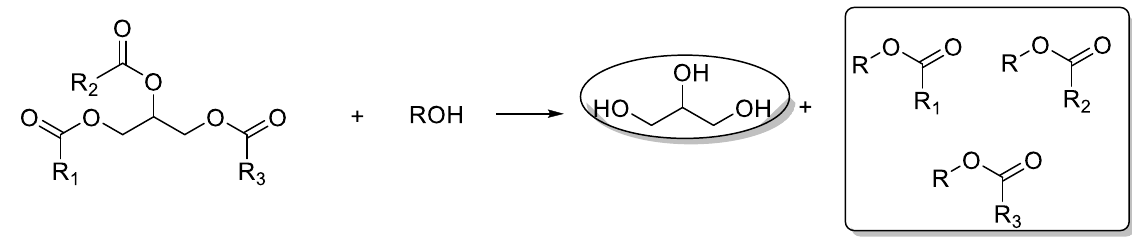
Figure 1. Transesterification reaction in biodiesel production.